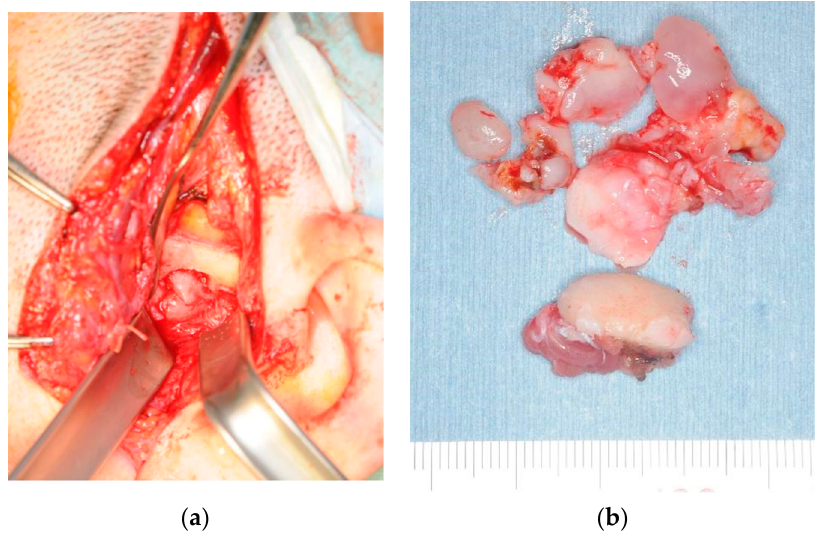
Figure 7. Photographs of intraoperative and excised material in patient 2. ( a ) Intraoperative photo- graph showing preauricular incision and tumor resection, including the synovial disc and left head of the mandible, using open-joint capsule surgery under general anesthesia. ( b ) Excised tissues from patient 2. Several hard masses, 10–20 mm in diameter, are observed in the superior joint space.